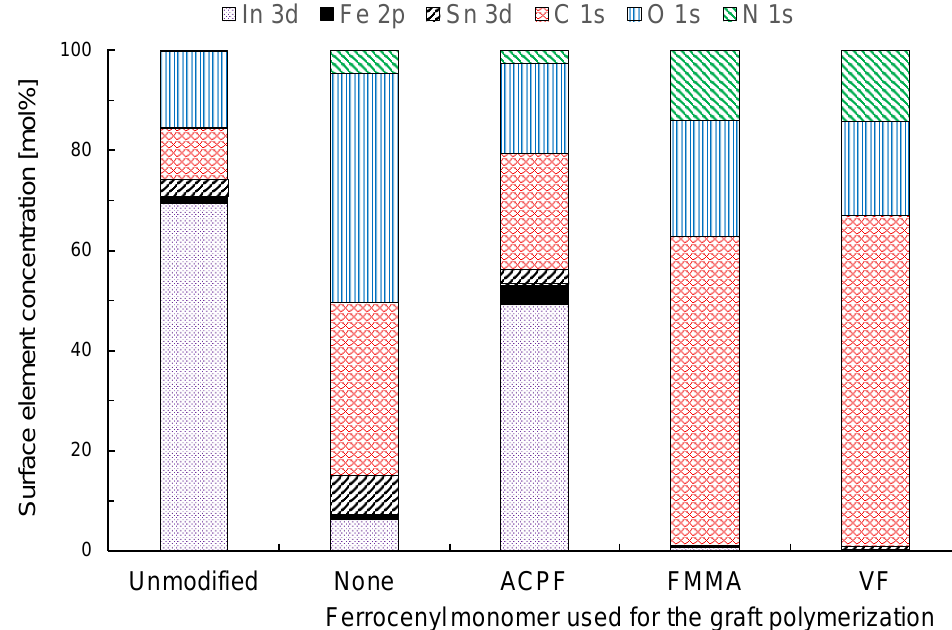
Figure 2. Elemental composition of each electrode surface.